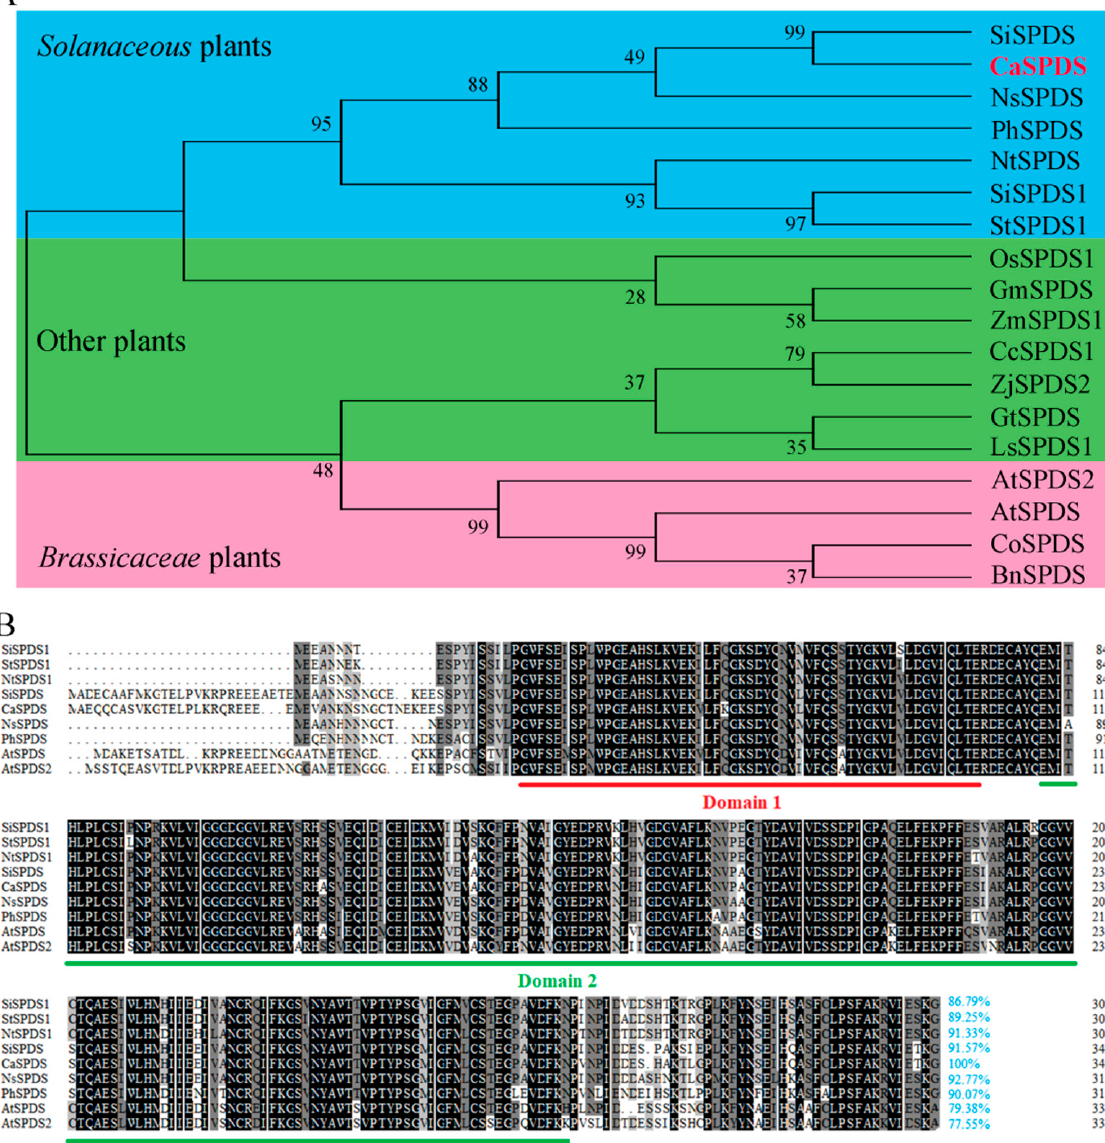
Figure 2. Phylogenetic tree and multiple sequence alignment of SPDS proteins. ( A ) Phylogenetic analysis of plant SPDS proteins. Red characters represent the SPDS protein in pepper. Blue background denotes Solanaceae plants, pink background denotes Brassicaceae plants, and green background denotes other plants. St: potato ( Solanum tuberosum L.); Si: tomato ( Solanum lycopersicum L.); Ph: petunia ( Petunia hybrida Vilm.); Nt: common tobacco ( Nicotiana tabacum L.) Ns: woodland tobacco ( Nicotiana sylvestris L.); At: Arabidopsis ( Arabidopsis thaliana ); Gt: gentian ( Gentiana triflora ‘SpB’); Ls: lettuce ( Lactuca sativa Linn.); Gm: soybean ( Glycine max L.); Zj: jujuba ( Ziziphus jujuba Mill.); Cc: clementine ( Citrus clementina ); Zm: maize ( Zea mays L.); Os: rice ( Oryza sativa L.); Bn: oilseed rape ( Brassica napus L.); Co: camelina ( Cochlearia officinalis L.). ( B ) Alignment of Arabidopsis and Solanaceae SPDS sequences. Domain1 (spermidine synthase tetramerisation domain) was labelled with red line, and domain2 (spermine/spermidine synthase domain) was labelled with green lines.